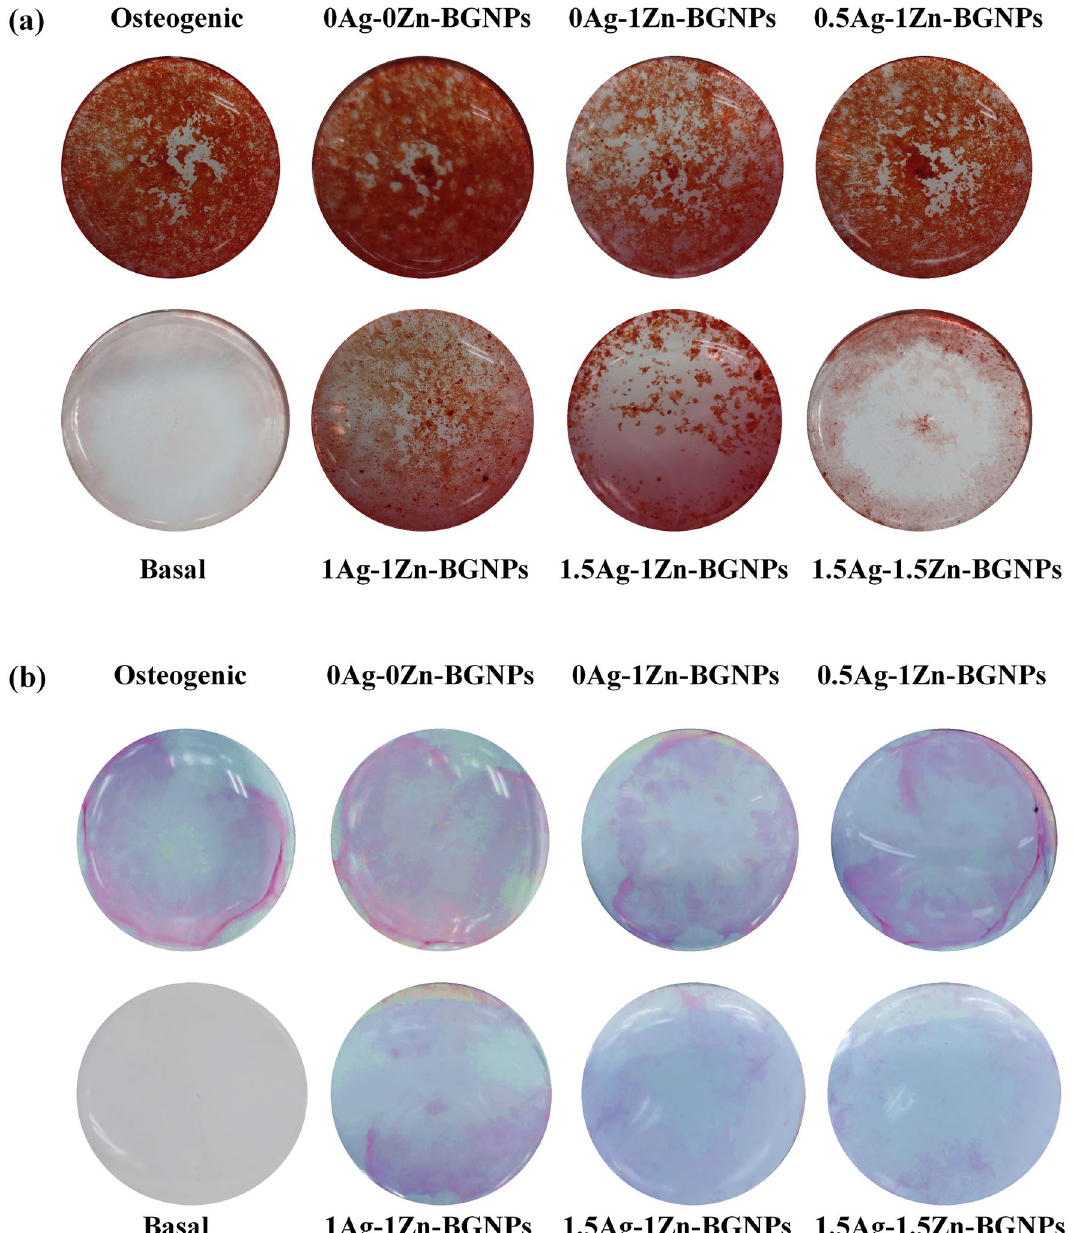
Figure 10. Osteogenesis macroscopic of treated hFOB 1.19 with particles at the concentration of 125 µg/mL ( a ) stained by Alizarin Red S staining and ( b ) stained by ALP activity staining kit following 21 days in culture. The basal and osteogenic media served as the negative and positive control,